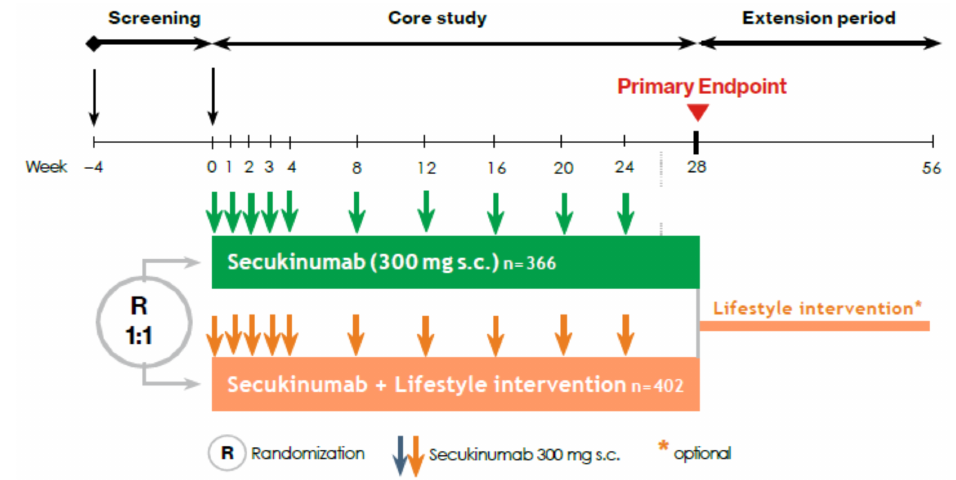
Figure 2. METABOLyx study design. METABOLyx is an open-label randomized controlled